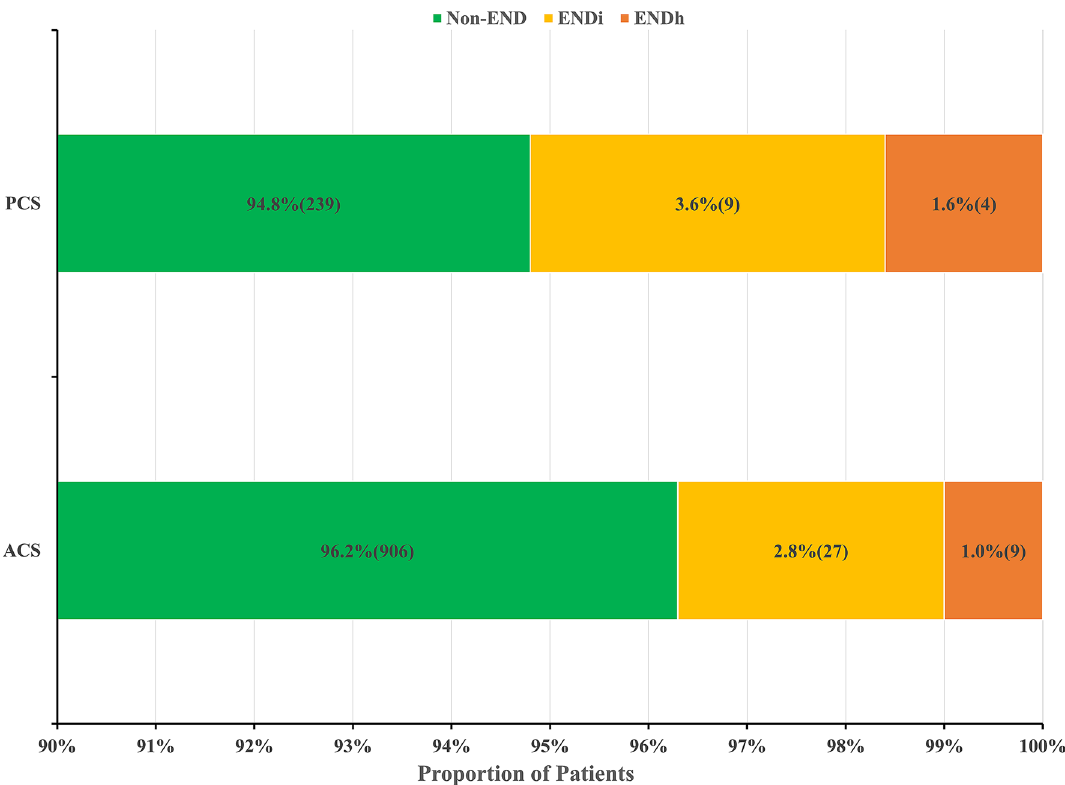
Figure 2. Proportion of patients in anterior vs posterior circulation stroke groups. ACS anterior circulation stroke, END early neurological deterioration, ENDi END due to ischemic injure; ENDh END due to hemorrhagic injure, PCS posterior circulation